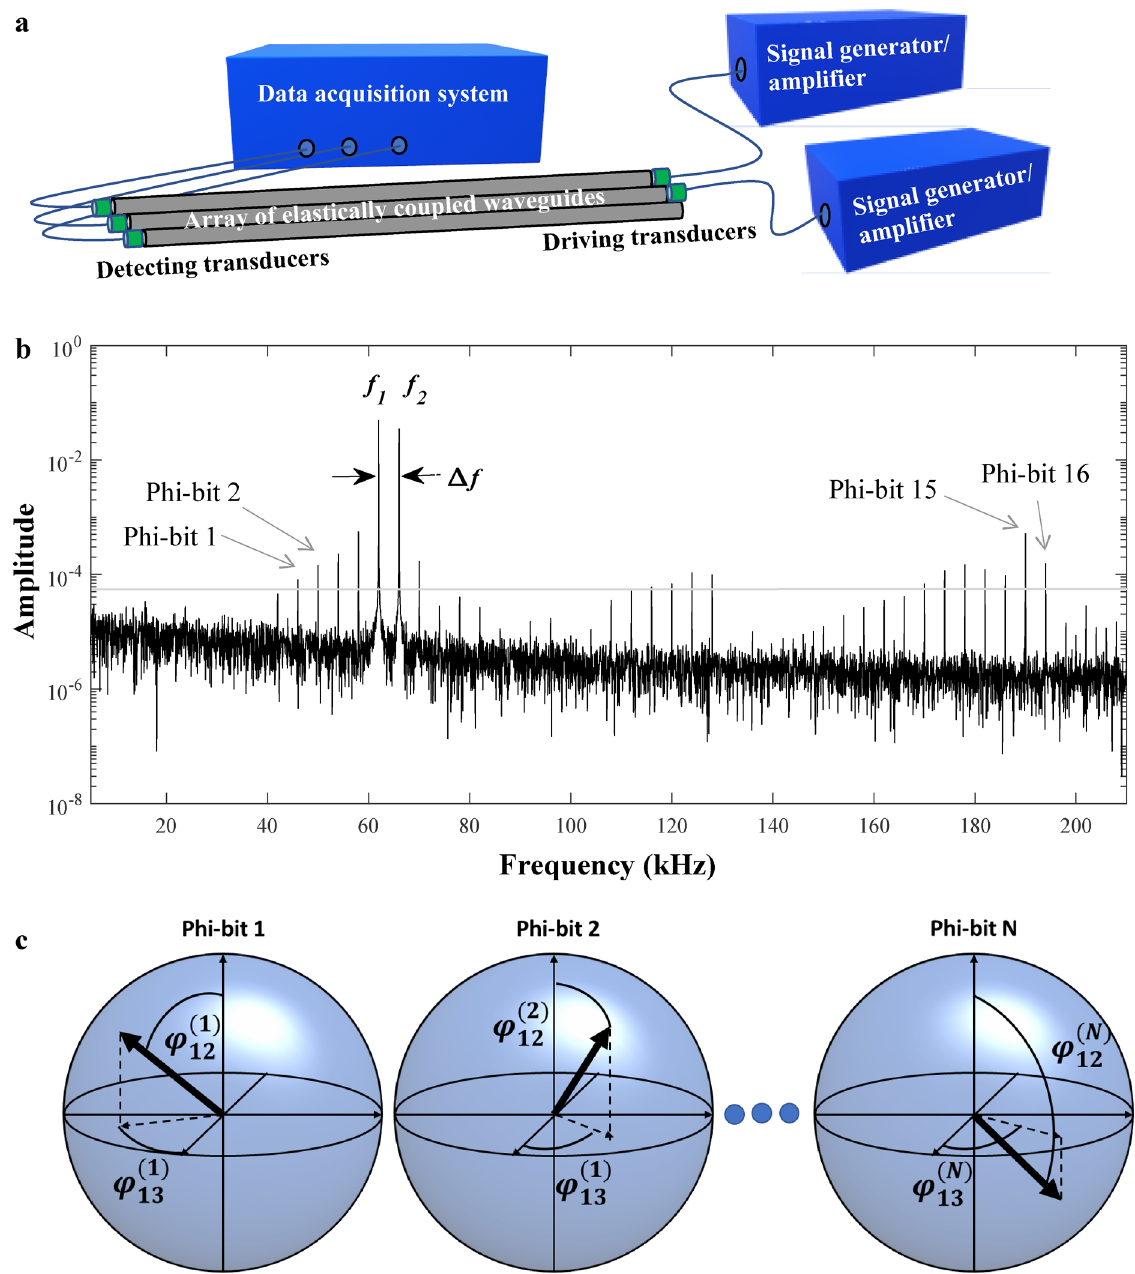
Figure 1. Experimental realization of two-level acoustic qubit-analogue i.e., logical phi-bits. ( a ) Schematic illustration of the experimental nonlinear acoustic waveguide-transducer-amplifier-generator platform. ( b ) Temporal Fourier transform of the rod amplitude, revealing the selection of logical phi-bits. The phi-bits are labelled from the first one to the 16th one in order of increasing frequency. The light grey horizontal line indicates the amplitude threshold for selection of phi-bits. System parameters: f 1 = 62 kHz , f 2 = 66 kHz , (cid:31) f = f 2 − f 1 . ( c ) Schematic illustration of N two-level phi-bit multipartite (cid:31) (cid:31) (cid:31) (cid:31)